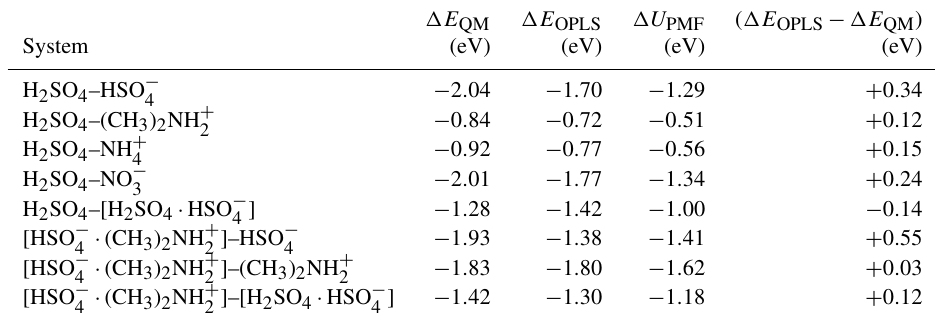
Table B1. Binding energies of collision systems obtained from ab initio calculations, (cid:49)E QM and using the OPLS force field, (cid:49)E OPLS , and the well depth of the potential of mean force at T = 300K, (cid:49)U PMF . (cid:49)E QM (cid:49)E OPLS (cid:49)U PMF ( (cid:49)E OPLS − (cid:49)E QM ) System (eV) (eV) (eV)